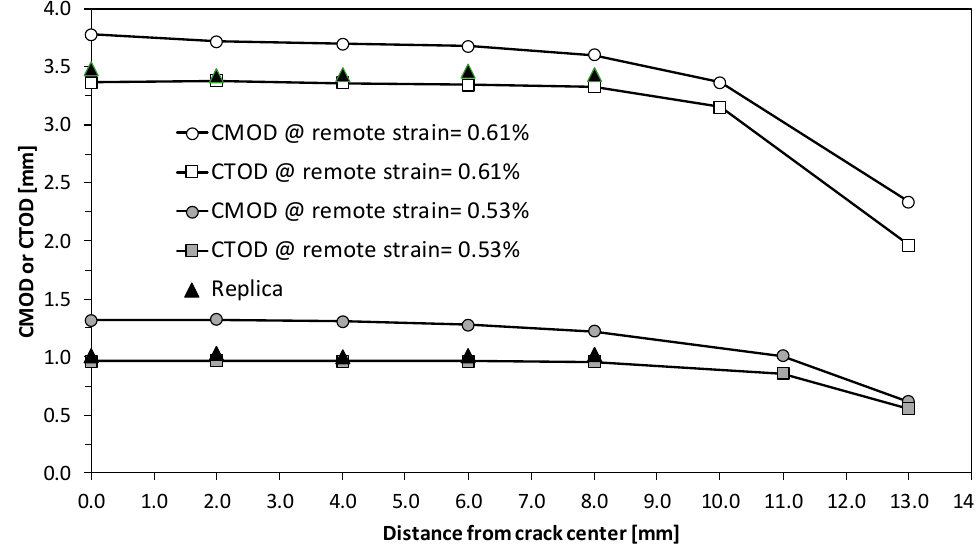
Figure 6. CMOD and CTOD ( δ 90 ) measured by DIC along the crack front at two levels of remote strain compared with CTOD measured using the replica